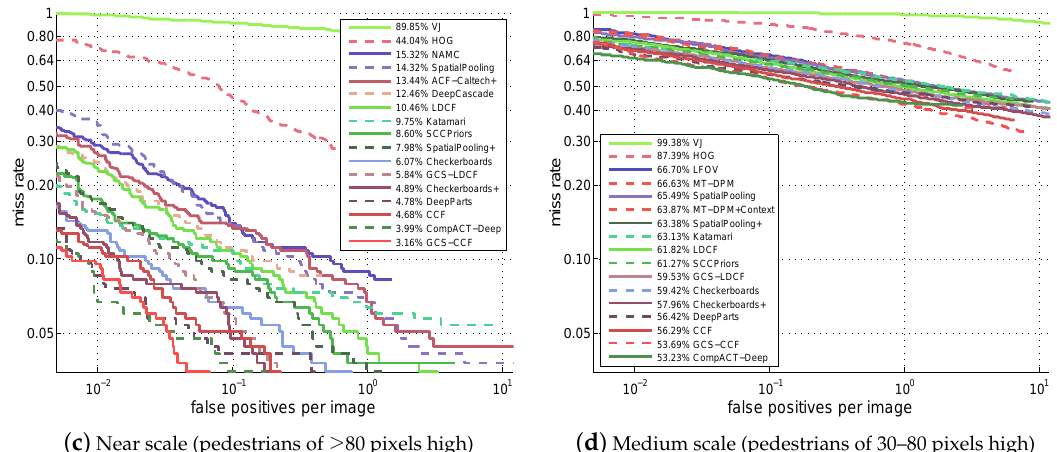
Figure 3. Comparison with popular approaches on the Caltech